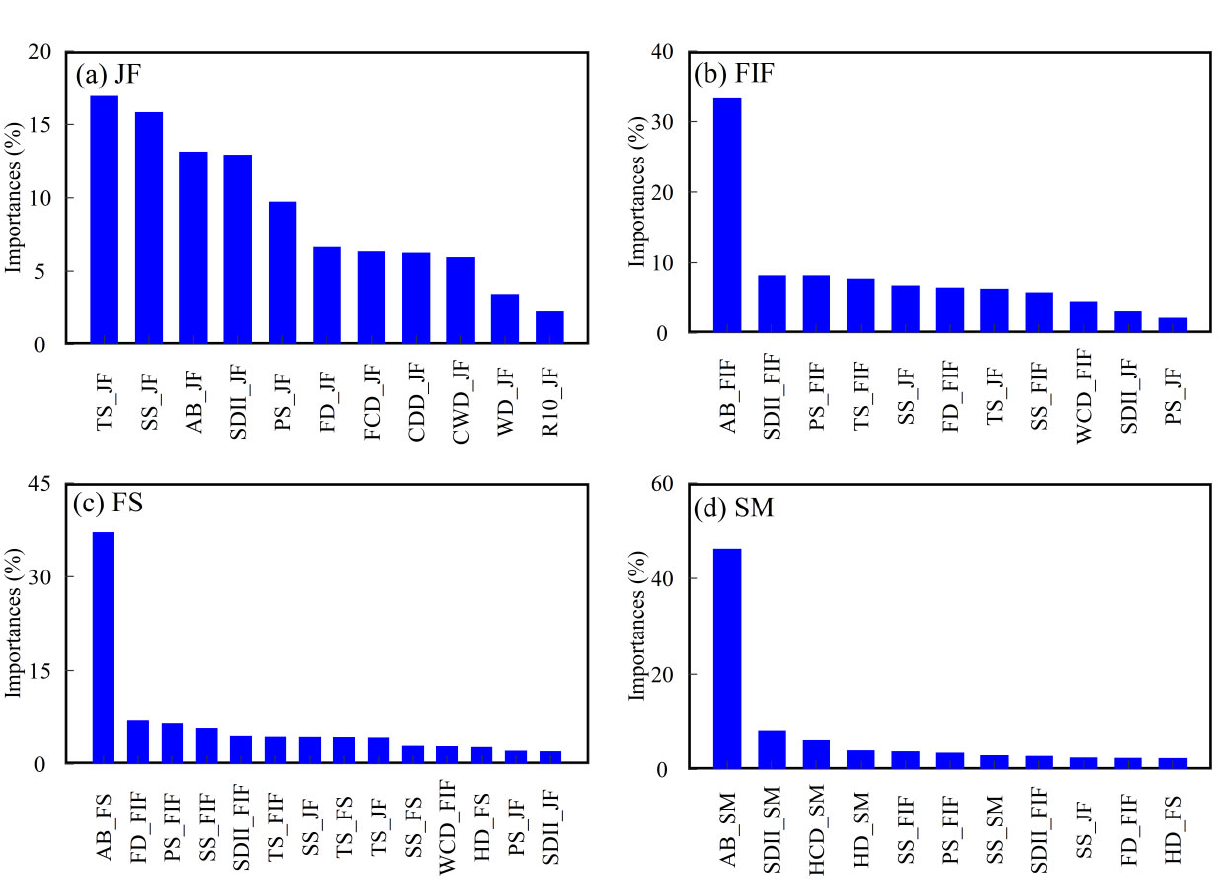
Figure 8. Relative importance of the input predictors as determined from the average of LGB (light gradient boosting machine) model and RF (random forest) model for the period from the end of the juvenile stage to floral initiation (JF) ( a ), from floral initiation to flowering (FIF) ( b ), from flowering to the start of grain filling (FS) ( c ), and from the start of grain filling to the milky stage (SM) ( d ). The results are normalized to sum 100% and shown in decreasing order in the figure (The input predictors lower than 2% were not shown in the figure).